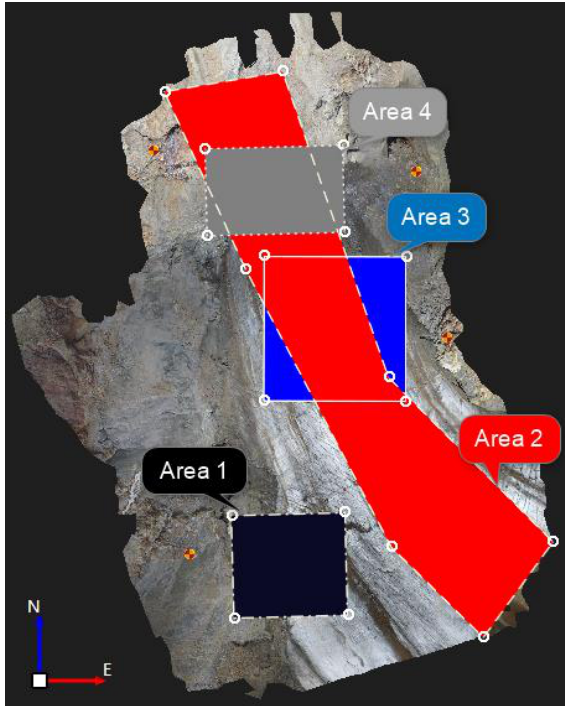
Figure 5. Position and extension of the areas of interest for the volume computation.